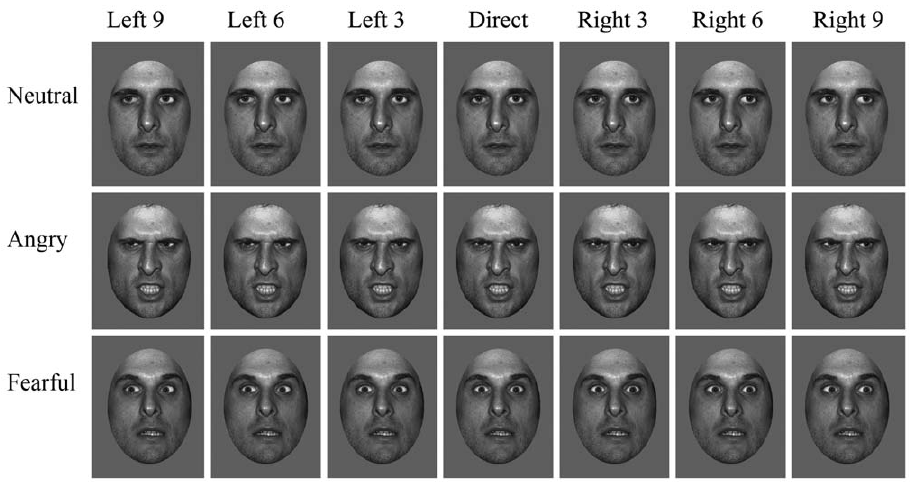
Figure 1. Neutral, angry and fearful expressions for three male identities showing the seven different eye gaze directions used here. This figure was adapted from Fig. 1 in [8] http://www.journalofvision.org/content/9/12/16.full?sid=62b18262-1084-4efe-8f2d-abb0c78eaf0f.